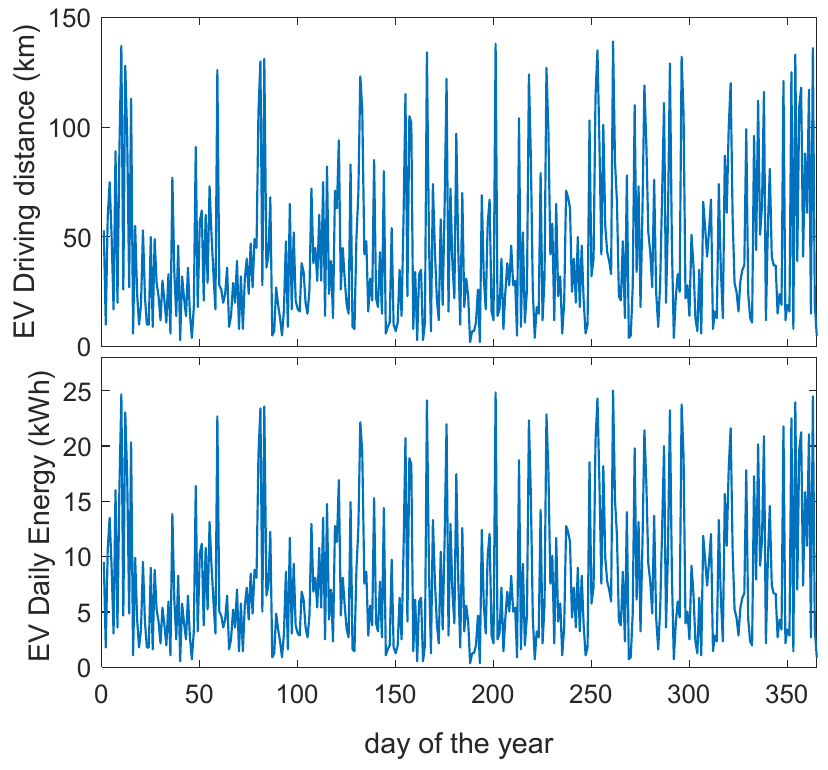
Figure 3. The daily distance and energy consumed by each EV.